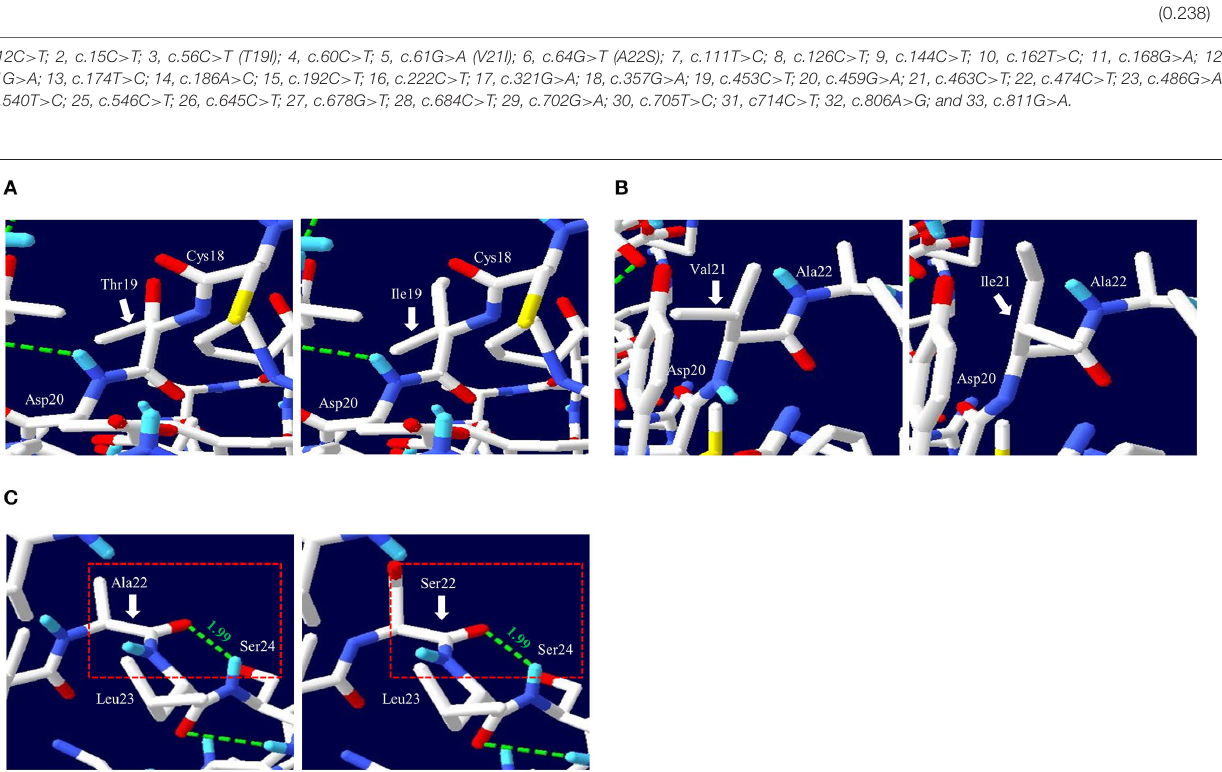
Electropherograms of the 33 novel SNPs are shown in Figure 1B